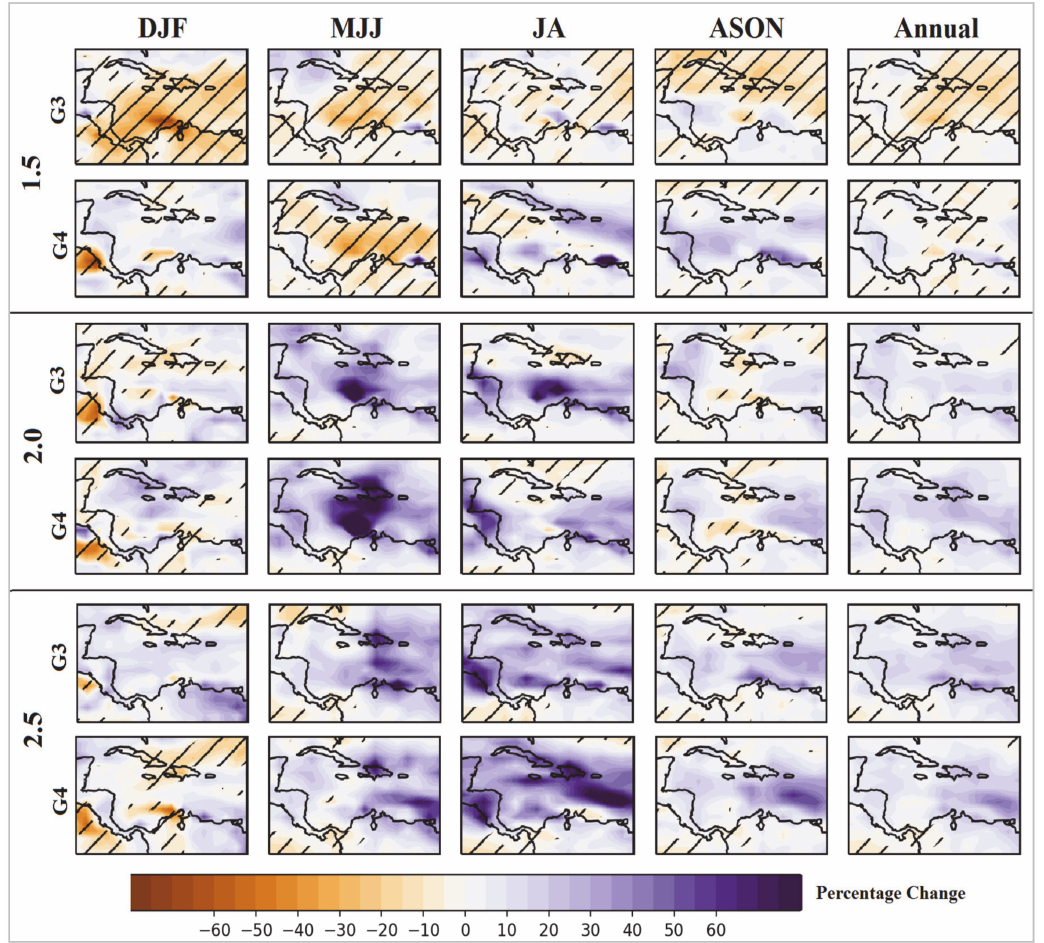
Figure 9. Same as Figure 8 but for percentage change in precipitation. Units are in